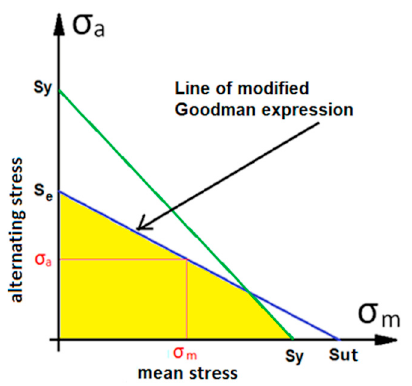
Figure 4. Graph of the relationship between mean stress σ m supported by the bolt and maximum allowable alternating stress σ a . In this graph S ut is the ultimate tensile strength and S e is the stress for unlimited life of the material (10 6 cycles in this case) and S y the yield strength of the material.